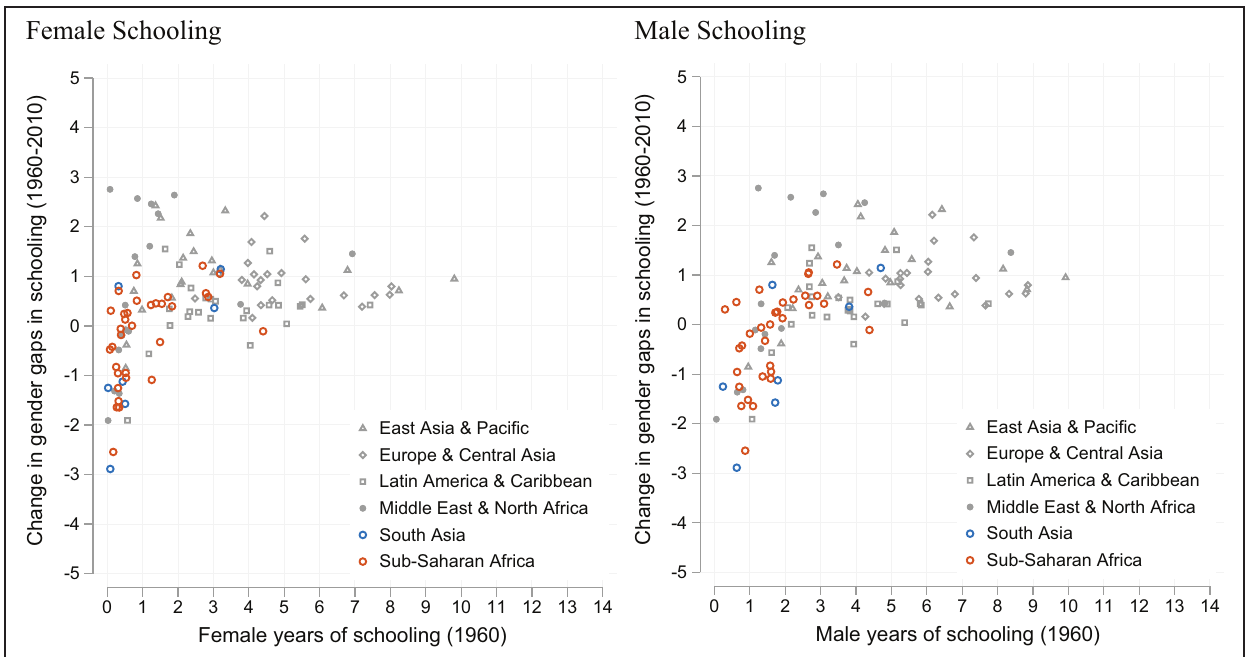
Figure 4 Change in Gender Gap in Average Schooling Years Given Schooling Levels in